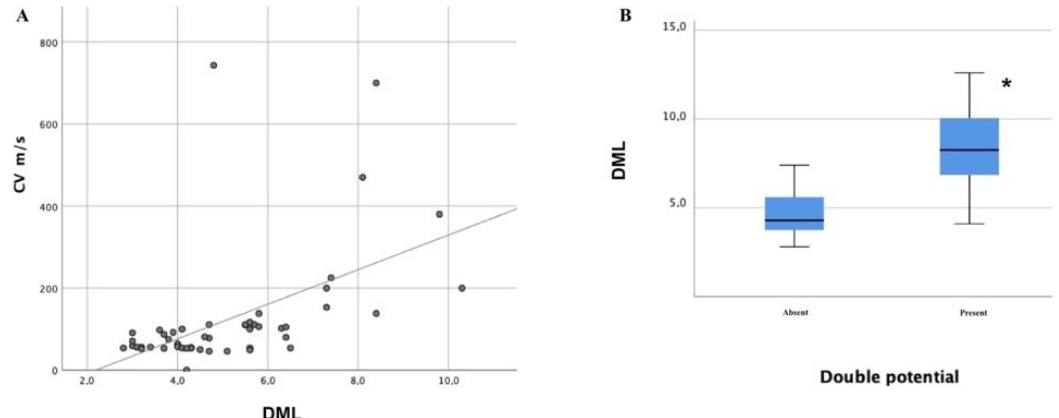
Figure 1. Correlation between DML, double potential, and CV in patients with MUC and CTS. ( A ) The linear correlation between median nerve CV and DML from NCS recording from APB. ( B ) The distribution of double potentials among MUC patients depending on the DML of the median nerve. MUC—median-to-ulnar communicating branch; CTS—carpal tunnel syndrome; CV—conduction velocity; DML—distal motor latency; NCS—nerve conduction studies; APB—abductor brevis pollicis muscle; * p < 0.0001.